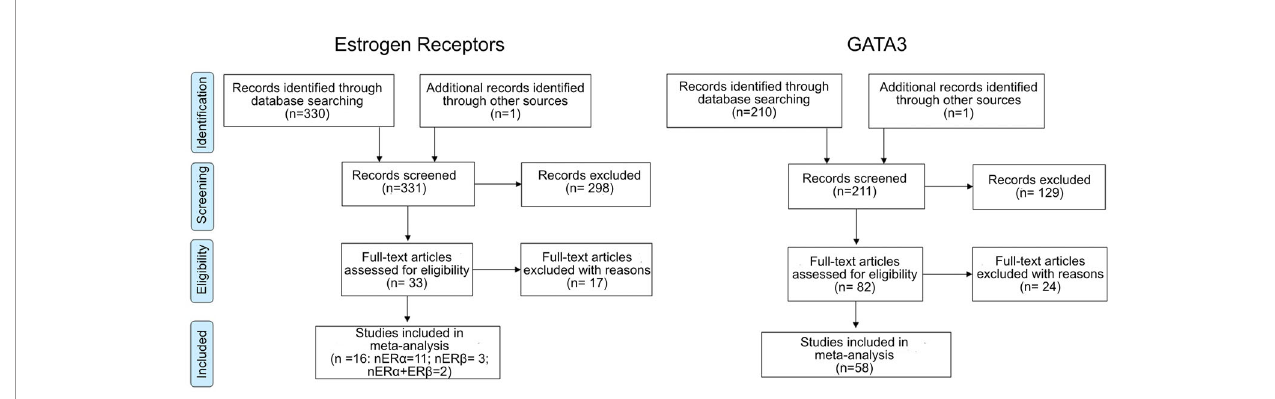
FIGURE 1 | Flowchart summarizing the literature selection process for Estrogen Receptor (ER a and ER b ) and GATA-binding factor 3